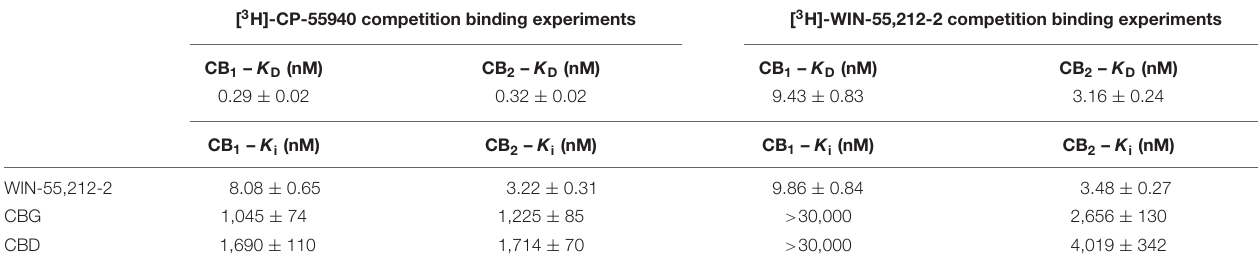
TABLE 1 | Affinity values of CB compounds obtained from radioligand binding assays. [ 3 H]-CP-55940 competition binding